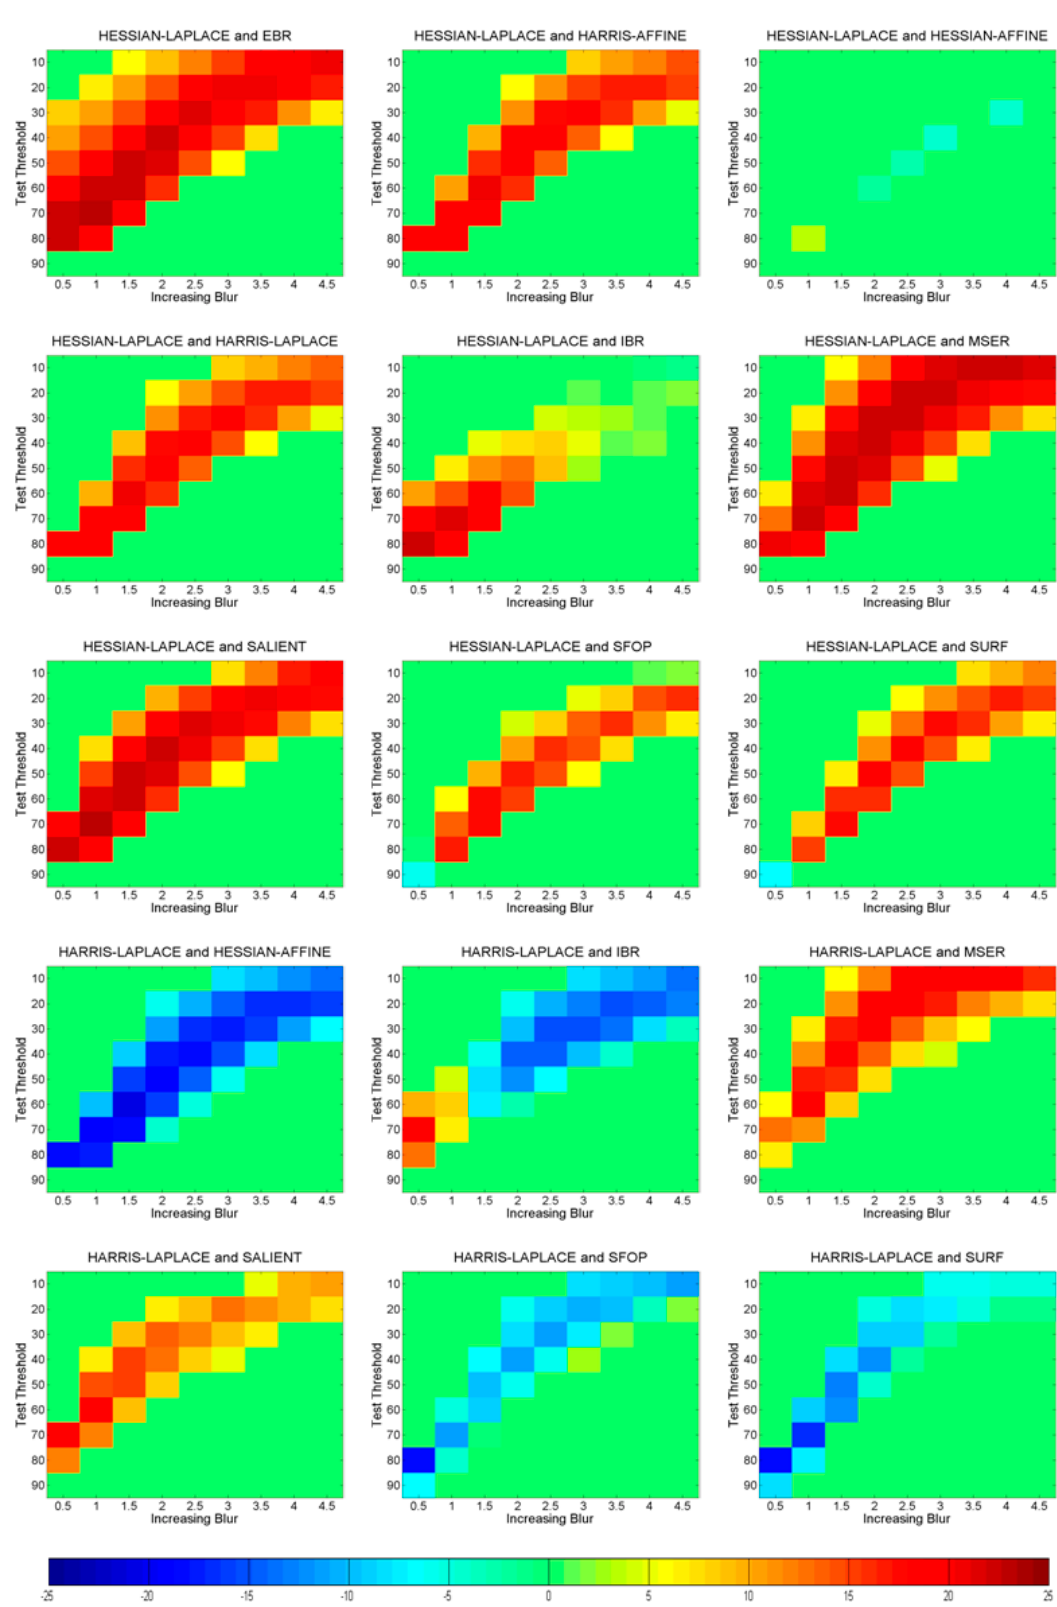
Figure 13. Results of blur changes for Harris-Laplace and Hessian-Laplace with other detectors showing Z -scores obtained; positive Z -scores indicate that the first detector is better than the second whereas negative values show the converse.